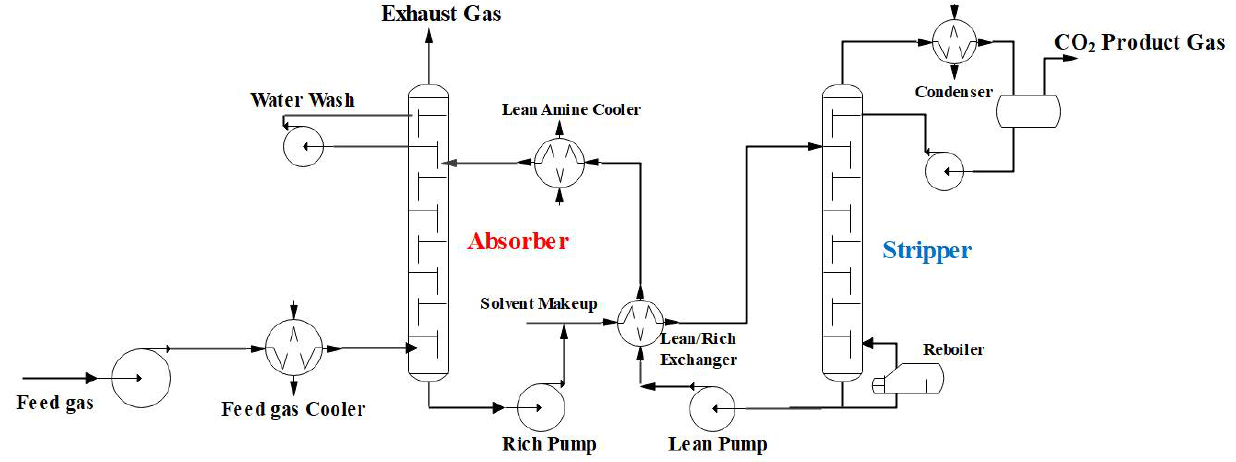
Figure 3. Typical chemical absorption separation CO 2 process [16].